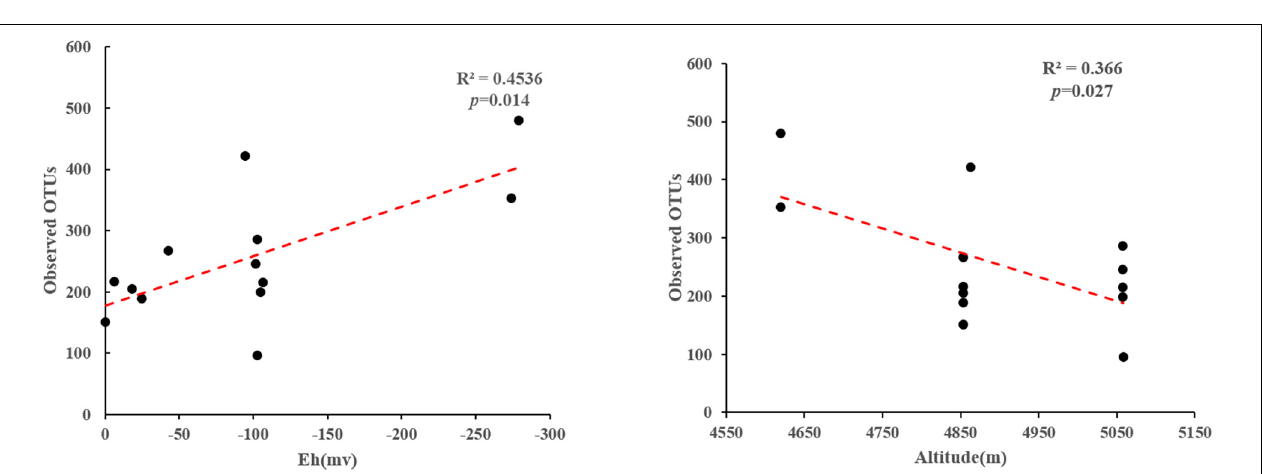
FIGURE 3 | Linear regression analyses showing correlations between the observed OTUs and measured environmental factors of the studied